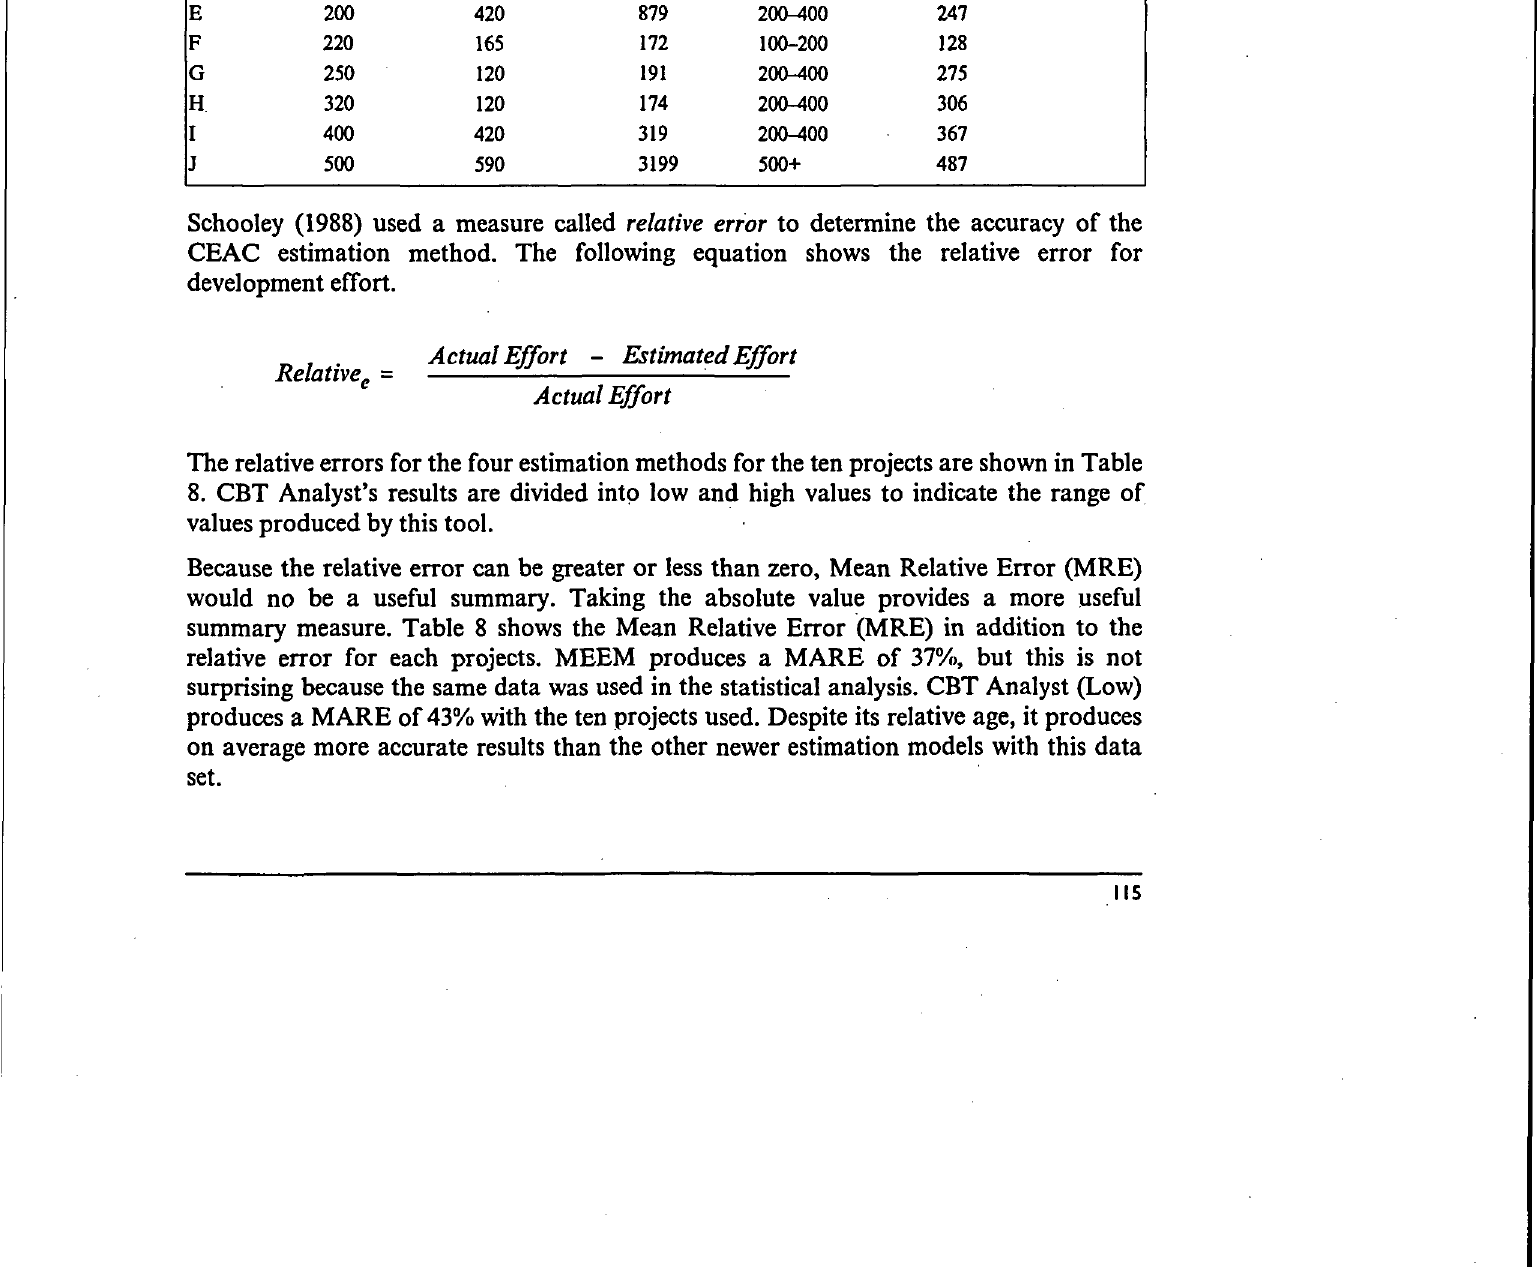
Table 7: Comparison of estimates and actual development